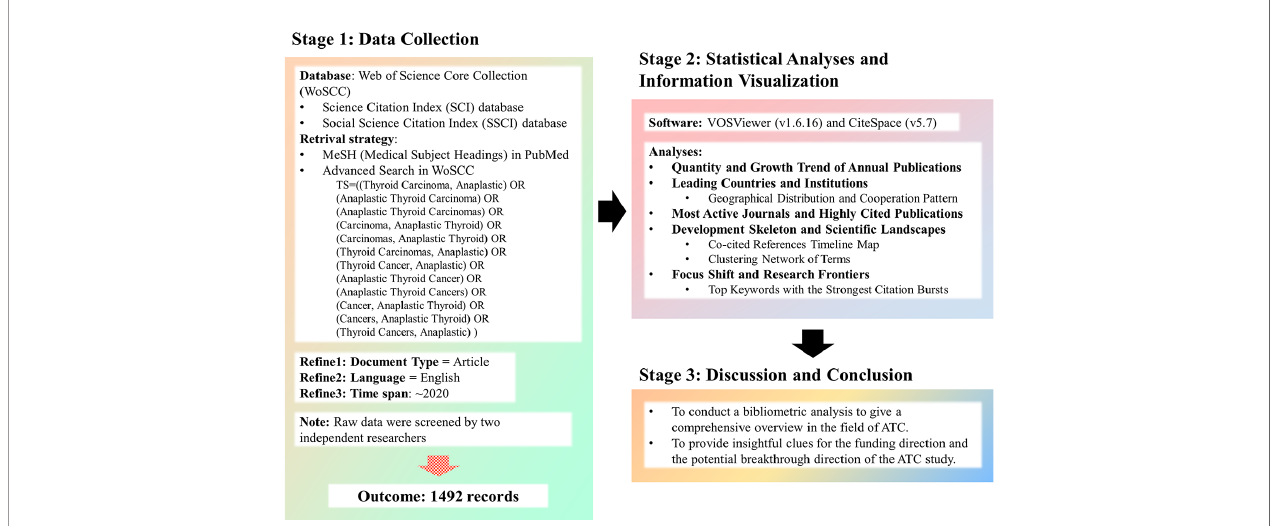
FIGURE 1 | The fl ow chart of the